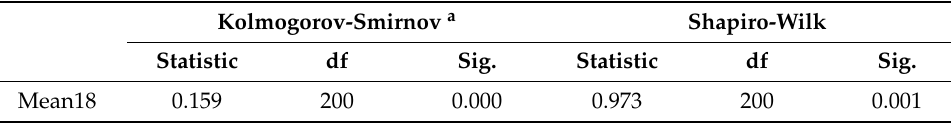
Table 3. Tests of normality.